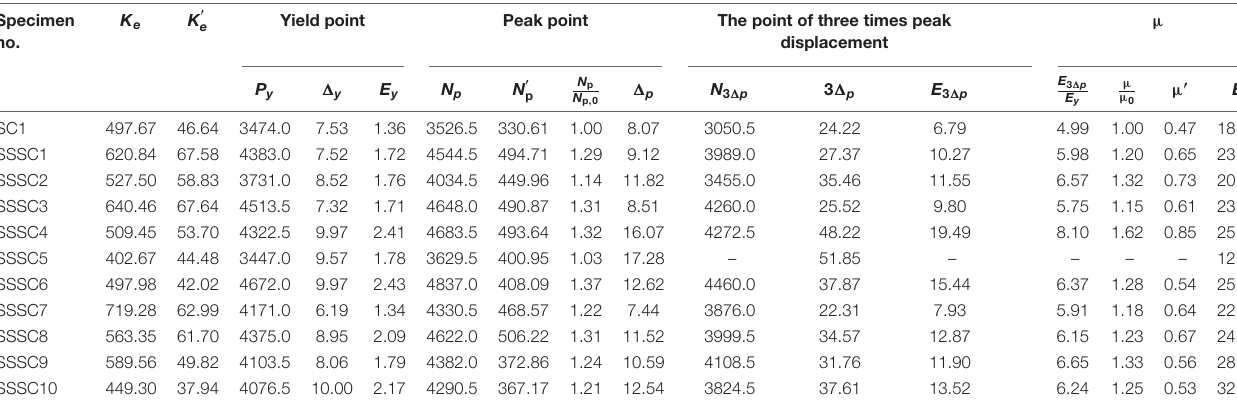
TABLE 3 | Parameters in feature